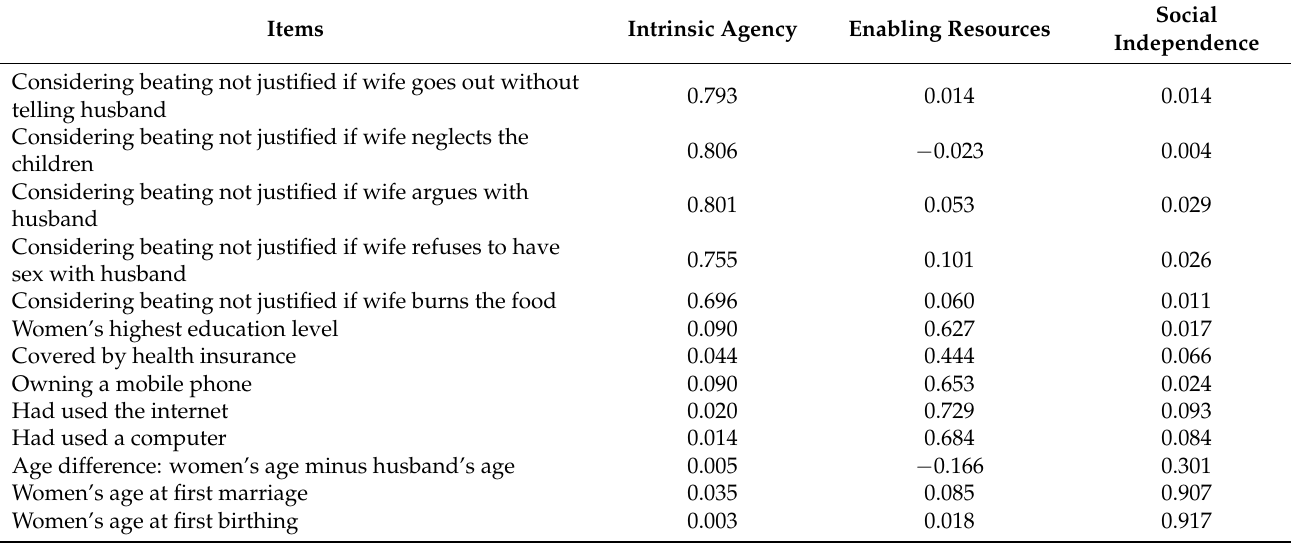
Table 1. Principal component analysis rotated factor loadings (N =